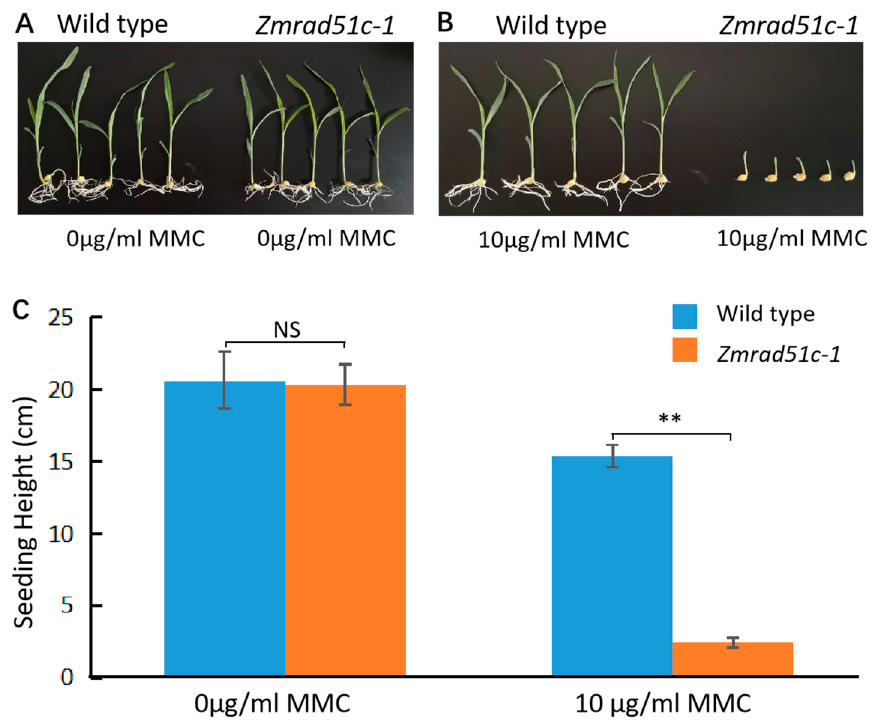
Figure 7. Zmrad51-1 is hypersensitive to MMC. ( A ) Wild type and Zmrad51c-1 showed similar height when growing on 1/2 MS medium without MMC for two weeks. ( B ) Zmrad51-1 seedlings (right) were significantly shorter than wild type (left) on 1/2 MS medium treated with 10 µg/mL MMC for two weeks. ( C ) Statistical analysis of wild type ( n = 10) and Zmrad51-1 ( n = 10) plant height. Values are means ± SE. Double asterisks indicates the statistical significance at p < 0.01 using a two-tailed Student’s t -test. NS means no significant difference.